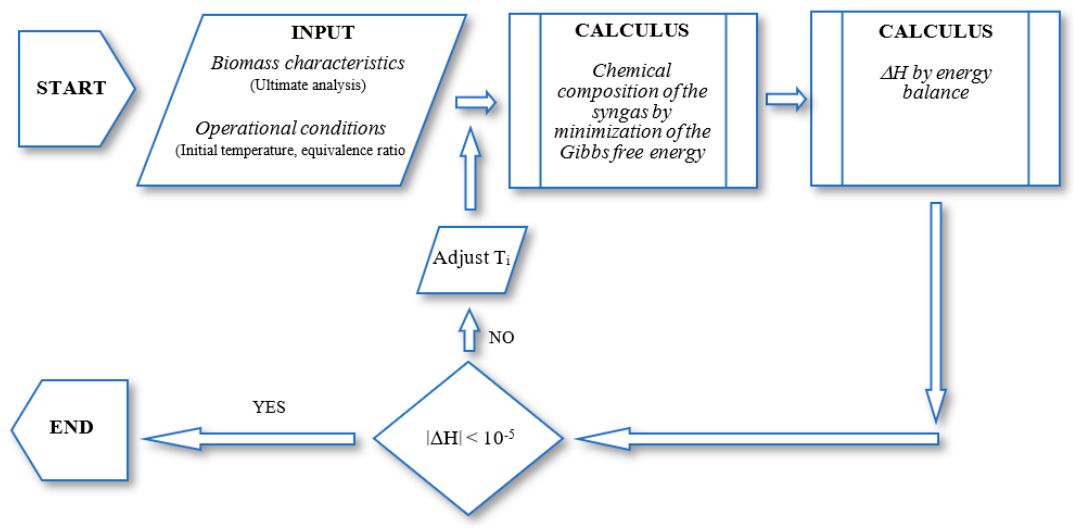
Figure 3. General flowchart of a non-stoichiometric model.